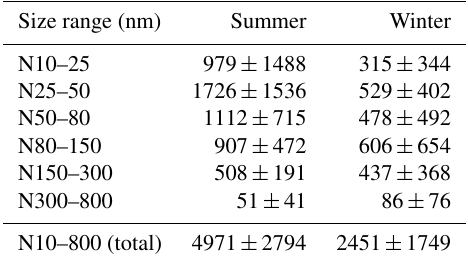
Table 1. Average cumulative particle number concentrations (cm − 3 ) measured by MPSS during the summer and winter cam-